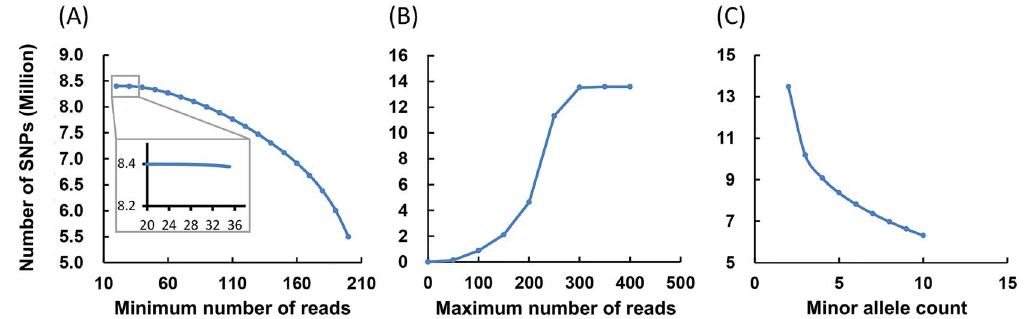
Figure 1. Influence of factors used for SNP filtering. ( A ) Influence of minimum reads on SNP identification. The x-axis represents the number of minimum reads used for SNP detection and the y-axis represents the number of SNP identified under a certain number of minimum reads. ( B ) Influence of maximum reads on SNP identification. The x-axis represents the number of maximum reads used for SNP detection and the y-axis represents the number of SNP identified under a certain number of maximum reads. ( C ) Influence of minor allele read counts on SNP identification. The x-axis represents the number of minor allele reads used for SNP detection and the y-axis represents the number of SNP identified under a certain number of minor allele reads.